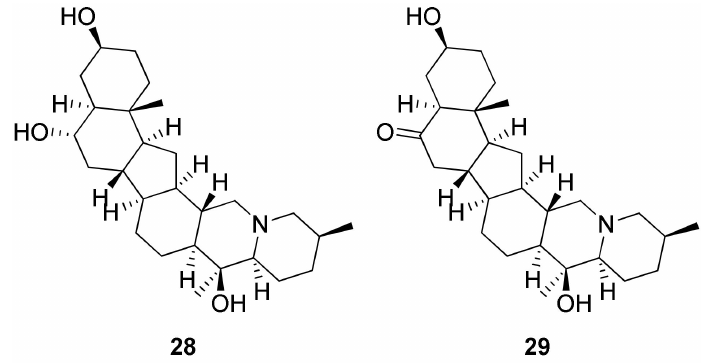
Figure 7. Structures of peimine 28 and peiminine 29 .